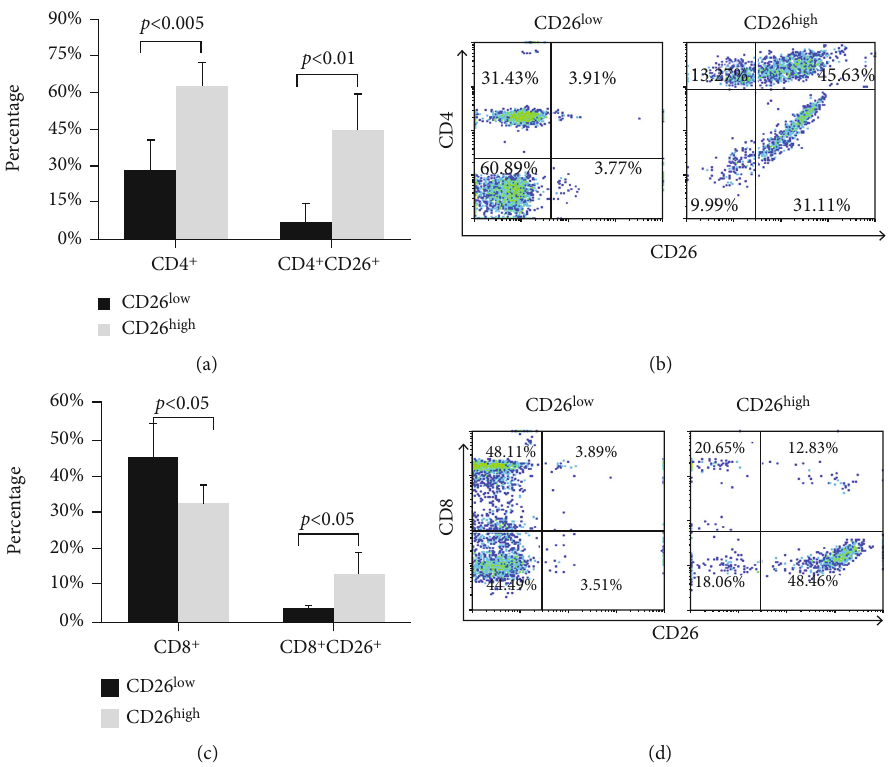
Figure 4: Percentages of CD4 + , CD8 + , CD4 + CD26 + , and CD8 + CD26 + cells in the CD26 low and CD26 high groups. (a) Percentages of CD4 + and CD4 + CD26 + cells in the CD26 low and CD26 high groups. (c) Percentages of CD8 + and CD8 + CD26 + cells in the CD26 low and CD26 high groups. Data represented meanvalue ± SD from seven independent experiments with seven healthy donor HPBL samples, and each experiment was repeated more than three times. Dot plots show the percentages of (b) CD4 + and CD4 + CD26 + cells and (d) CD8 + and CD8 + CD26 + cells in the CD26 low and CD26 high groups.